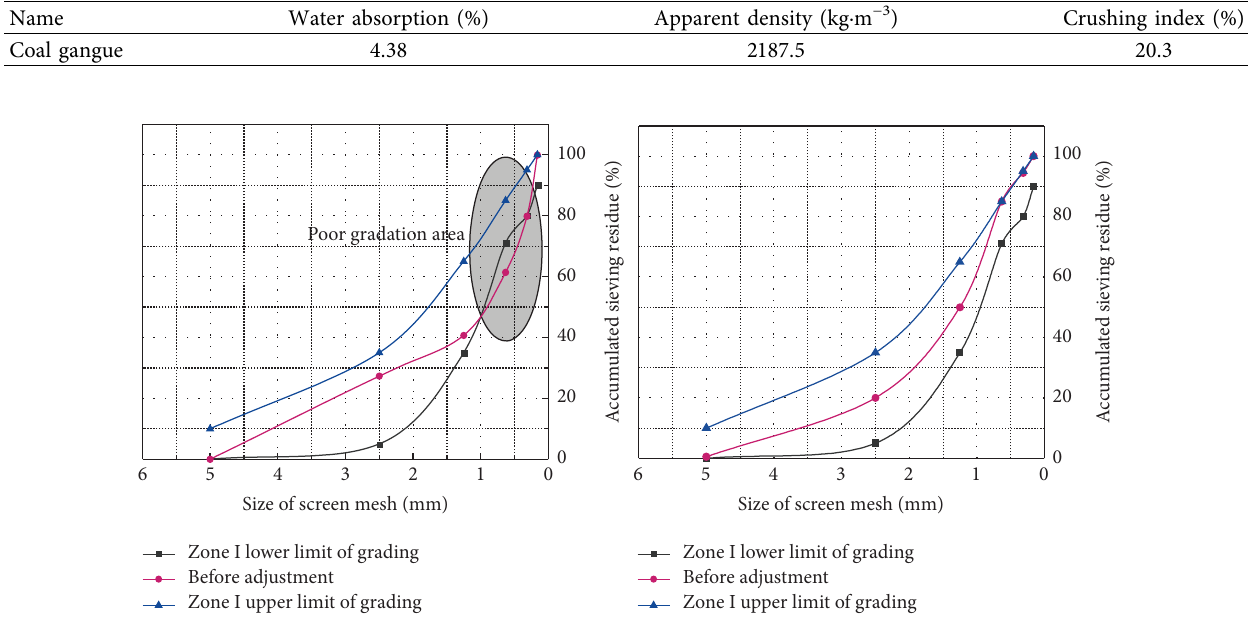
Table 1: Physical parameters of coal gangue.